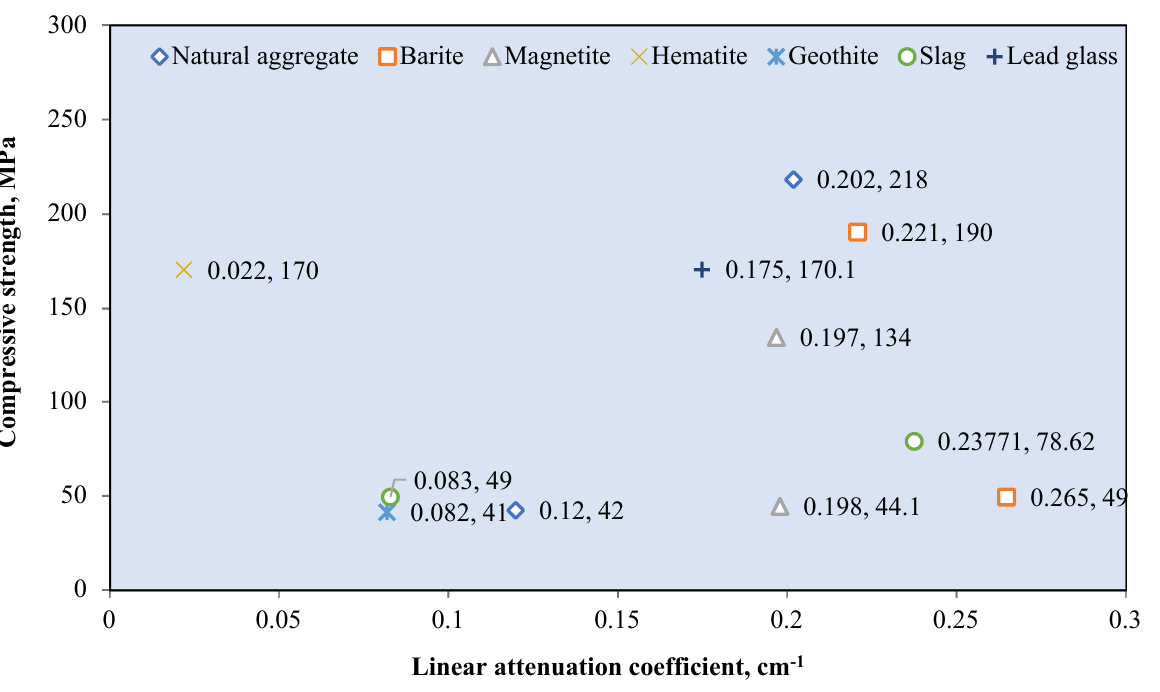
Figure 13. Compressive strength and linear attenuation coefficient of various RSCs (data adapted from [14,24,44–46,53,67,120,122]).